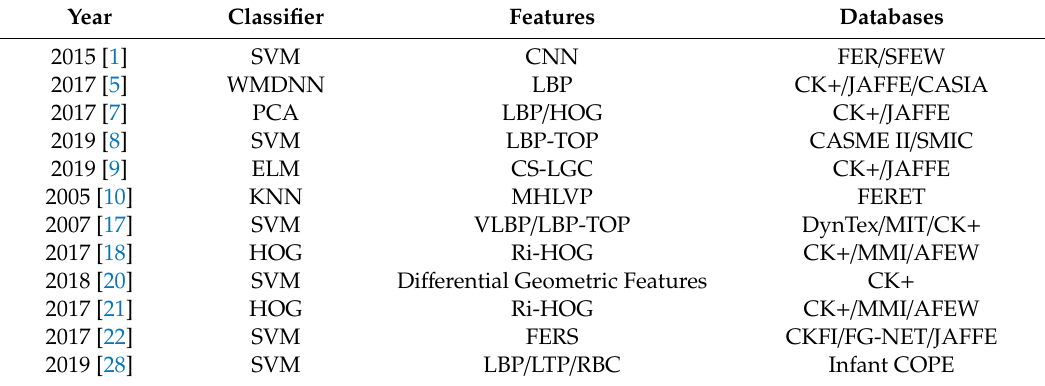
Table 1. Key information on some similar recently studied methods on facial expression recognition